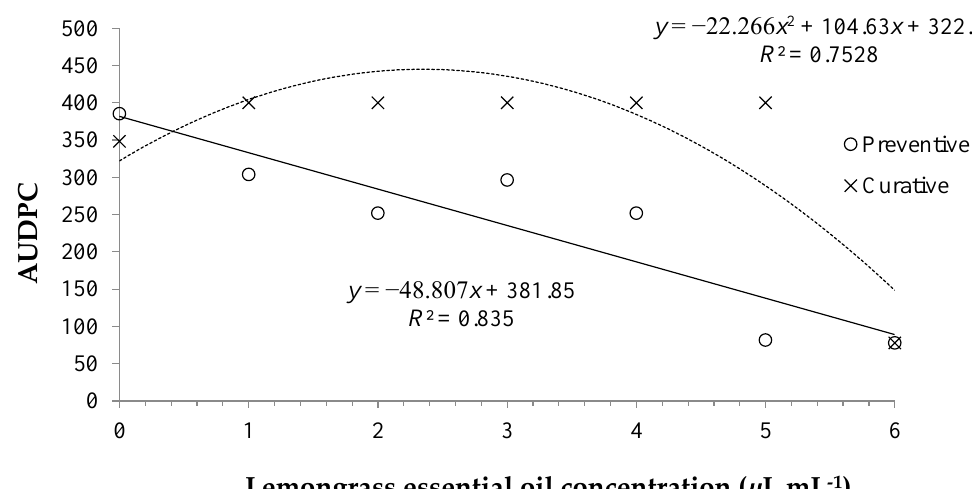
Figure 4. Area Under Disease Progress Curve (AUDPC) for preventive and curative in vivo under positive control with water (0 = 0.0 µ L mL − 1 ) and negative control with methyl-thiophanate (6 = 2.0 mg mL − 1 ), with five different concentrations (1 = 0.625 µ L mL − 1 , 2 = 1.25 µ L mL − 1 , 3 = 2.5 µ L mL − 1 , 4 = 5 µ L mL − 1 , and 5 = 7.5 µ L mL − 1 ) of the Cymbopogon citratus essential oil.